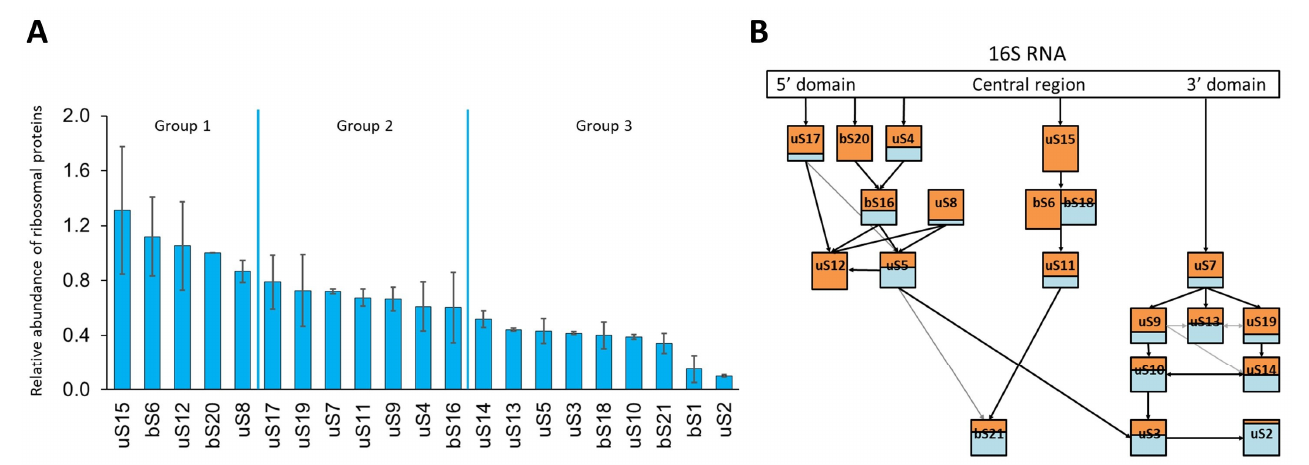
Figure 4. Relative quantification of 21S proteins by quantitative mass spectrometry. ( A ) Histogram of the ratio between purified 21S and 30S ribosomal particles analyzed by LC-MS/MS. Protein levels are normalized against those of the bS20 proteins used to purify the particles and are the means of three biological replicates, with standard deviation indicated. ( B ) Schematic representation of the proportion of ribosomal proteins in the Nomura assembly map, adapted from [7]. The ratio of proteins in 21S is orange, while the proteins from 30S are normalized to 1 and shown in blue.